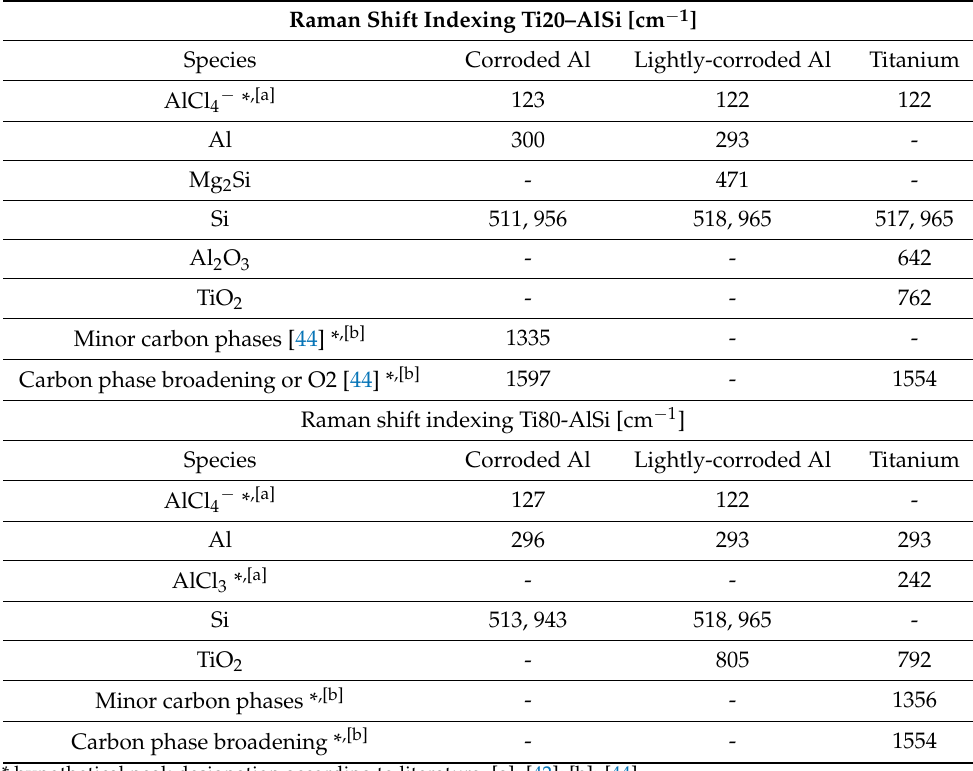
Table 6. Raman shift measured for (a) corroded aluminium; (b) spongy-like aluminium; (c)